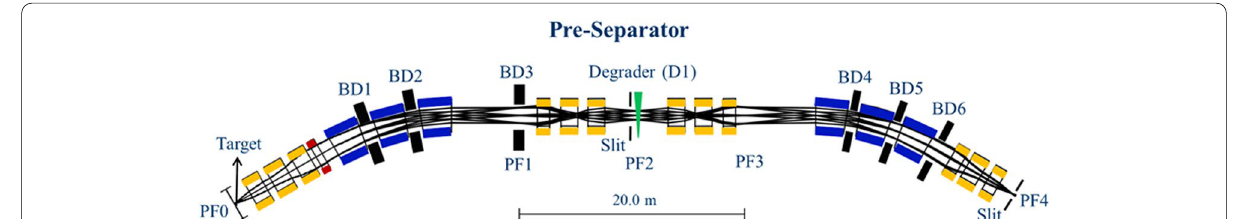
Fig. 8 Layout of the pre-separator. PF0-PF4 are the focal planes, and BD1-BD6 are the beam dumps. Ion trajectories with three divergence angles and three momentum deviations are schematically depicted in the first-order approximation. Dipole magnets are indicated in blue and quadrupole magnets in golden. The magnets are resistant to